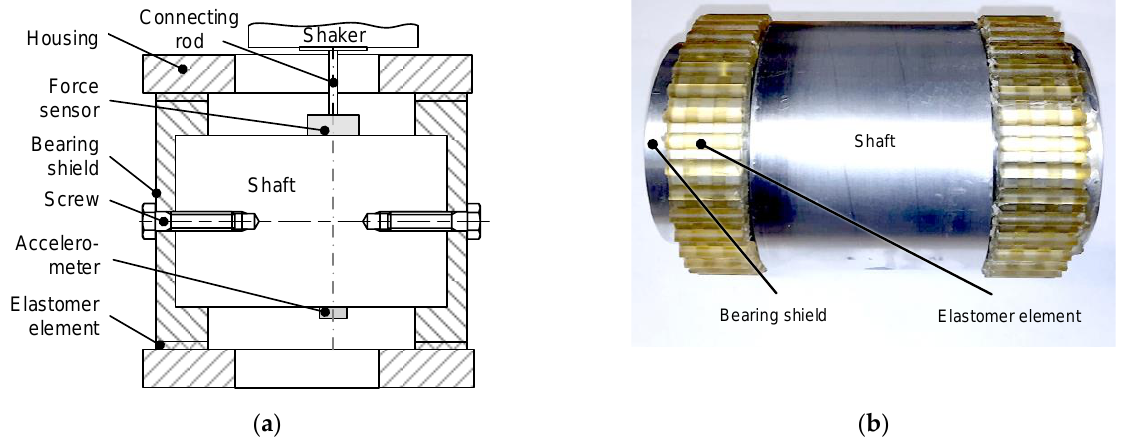
Figure 6. ( a ) schematic diagram of the test system; ( b ) shaft and bearing shield assembly with cast elastomer structure.